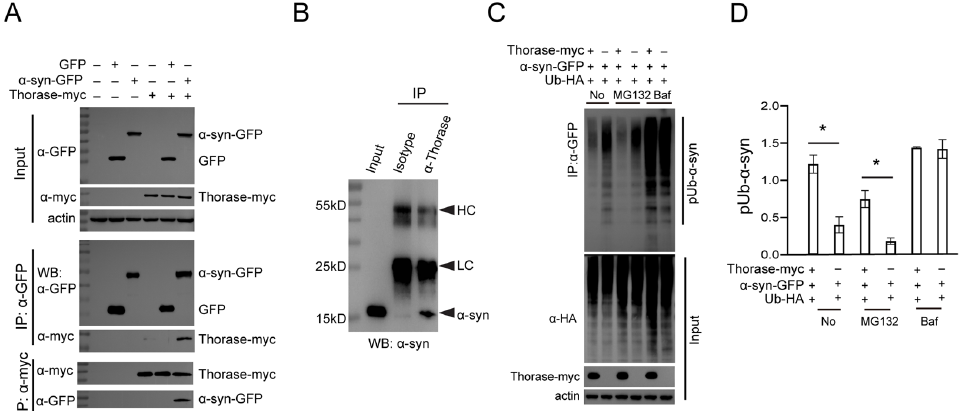
Figure 4. Thorase interacts with α -syn and regulates the degradation of ubiquitinated α -syn. ( A ) Coimmunoprecipitation (Co-IP) assay showing that Thorase interacts with α -syn. Thorase-myc and α -syn-GFP or GFP expression constructs were cotransfected into HEK293 cells. After 48 h, cell lysates were separated into two aliquots for immunoprecipitation assays with either an anti-GFP (CST, 1:1000) or an anti-myc antibody (CST, 1:1000). Western blotting was performed to examine the interaction of Thorase with α -syn by the use of an anti-myc or anti-GFP antibody. ( B ) Co-IP assay showing that endogenous Thorase interacts with endogenous α -syn in mouse brain lysates. Mouse isotype-IgG served as a negative control for the Co-IP experiment. Anti- α -syn antibody (BD, 1:1000). ( C ) Thorase promotes the degradation of ubiquitinated α -syn. Ub-HA and α -syn-GFP expression constructs were cotransfected with or without Thorase-myc into HEK293 cells. After 24 h, ubiquitinated α -syn was examined by Western blot. Baf was used as a negative control. Anti-HA antibody (Abmart, 1:1000); anti-Thorase (Biolegend, 1:1000); anti- β -actin antibody (BOSTER, 1:2000). ( D ) Quantification of the level of the high-molecular-weight smear representing polyubiquitinated α -syn-GFP shown in panel ( C ). Data are presented as the mean ± SEM, determined by unpaired two-tailed Student’s t -test. * p < 0.05.